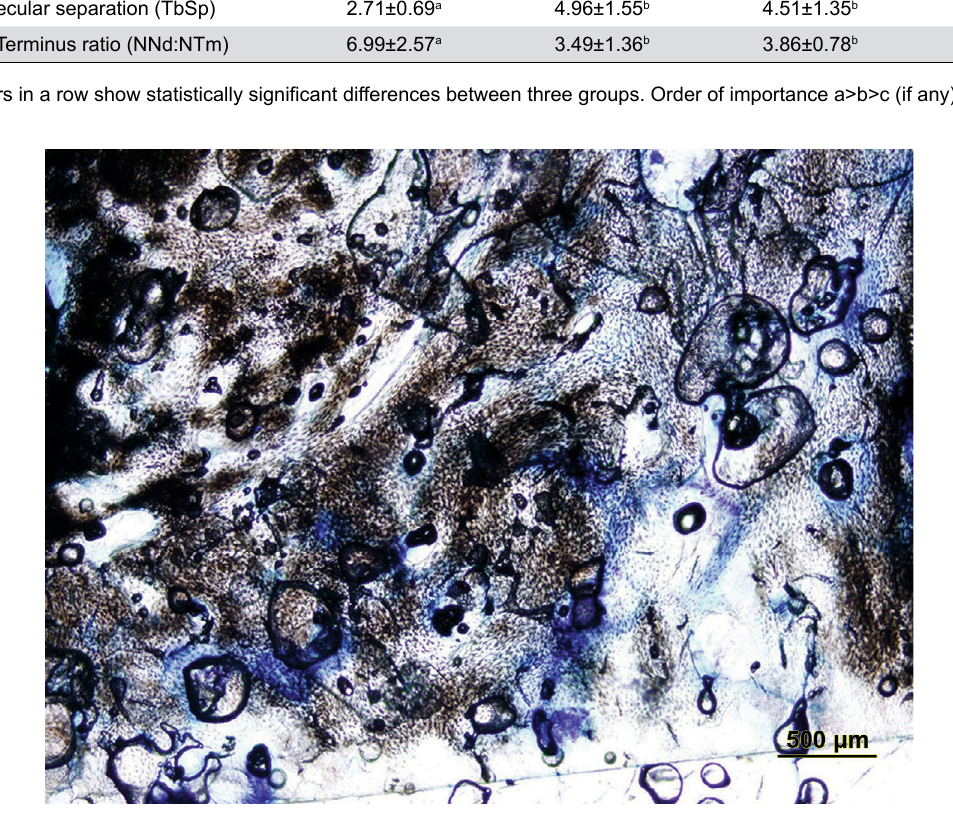
Figure 2- Histological transversal section stained with toludine blue in autograft group (original magnification